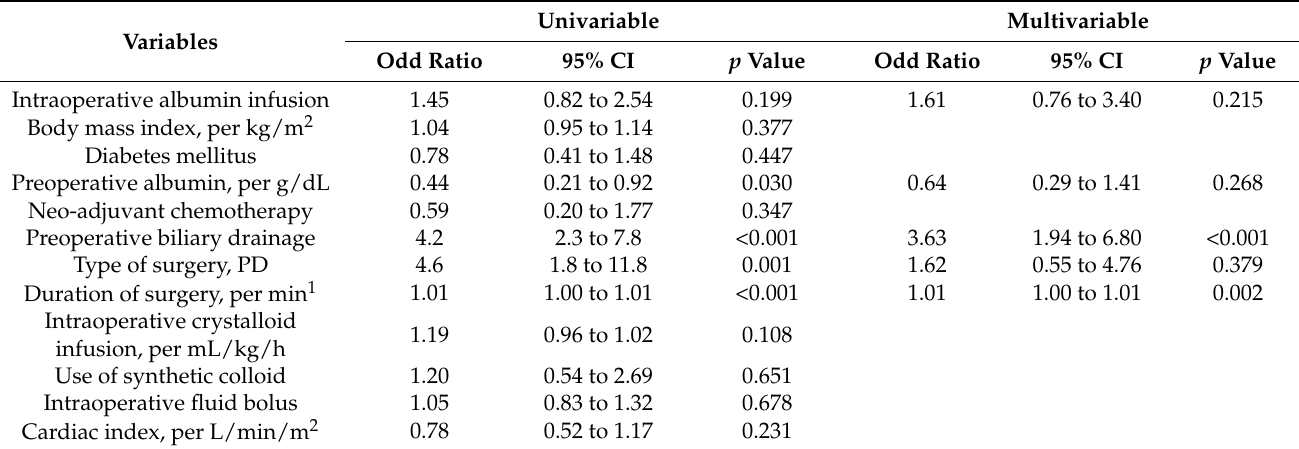
Table 3. Multiple logistic regression for predictors of Clavien–Dindo classification grade ≥